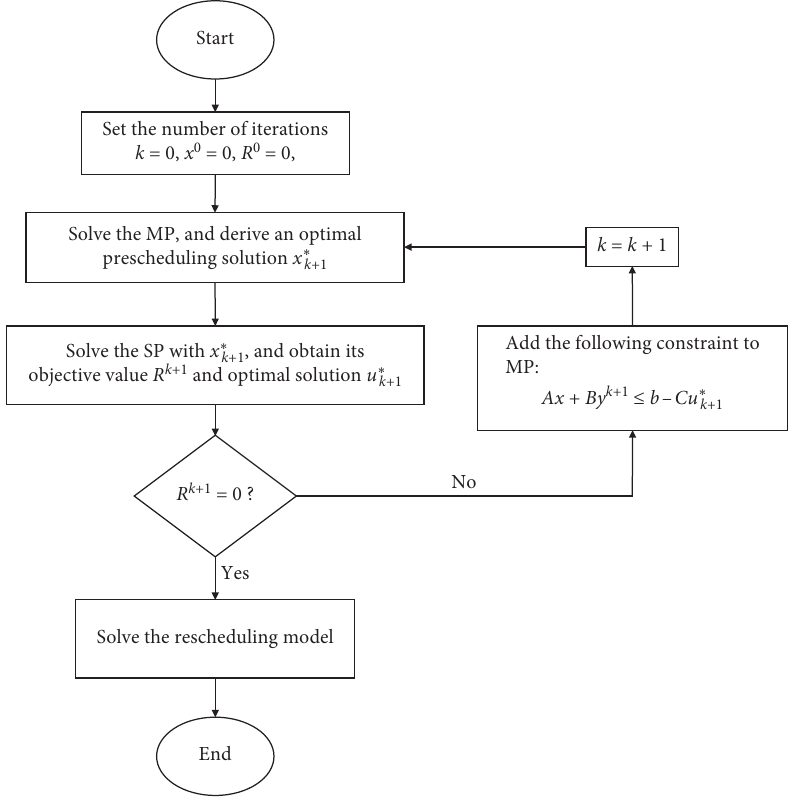
Figure 1: Diagram of the C & CG algorithm. Table 4: Parameters of DGs.